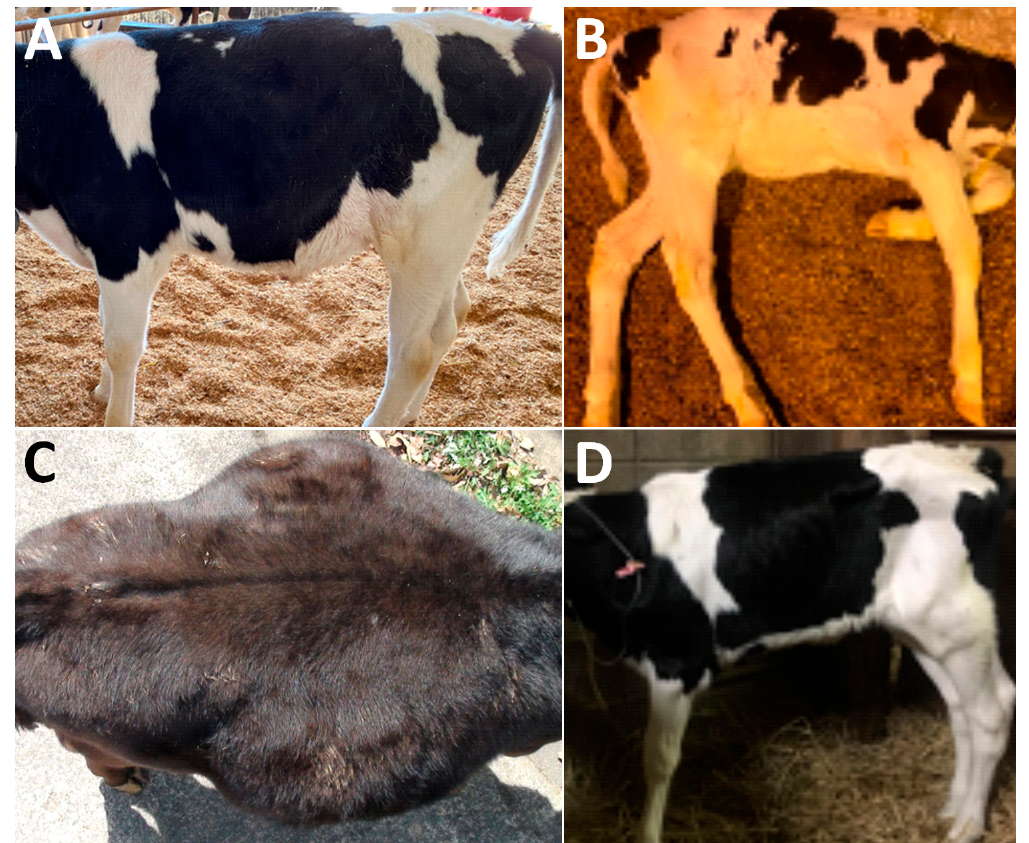
Figure 1. Macroscopic views of the abdomens of Case 2 ( A ), Case 4 ( B ), Case 8 ( C ), and Case 9 ( D ). ( A ) Abdominal distention is evident in the ventral region of the right flank. ( B ) Abdominal distention is not evident in either flank of the depressed, laying-down calf. ( C ) In the dorsal view, abdominal distention is markedly evident in both flanks. ( D ) Abdominal distention is not evident in either flank.